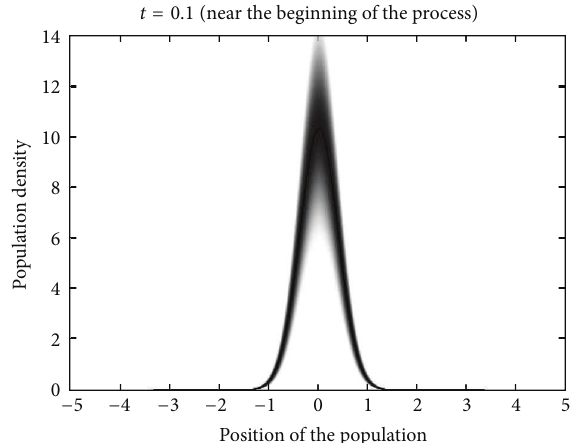
Figure 5: Dimensional graph of the fuzzy solution for 𝑡 = 0.01 involving only diffusion.